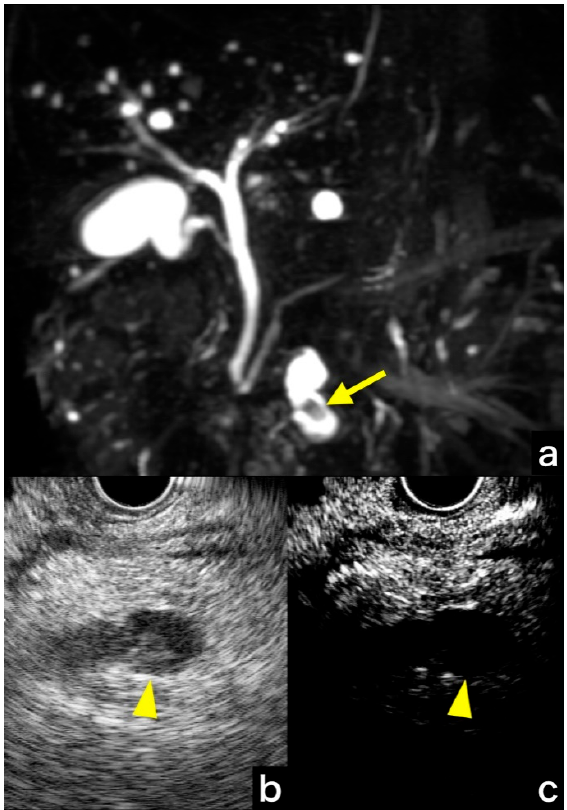
Figure 2. ( a ) MRCP shows a defect in the cystic lesion suspected as a mural nodule (arrow); ( b ) Fundamental B-mode EUS shows a suspected mural nodule (arrowhead); ( c ) Contrast-enhanced harmonic EUS shows the absence of enhancement (arrowhead). MRCP, magnetic resonance cholangiopancreatography; EUS, endoscopic ultrasound.